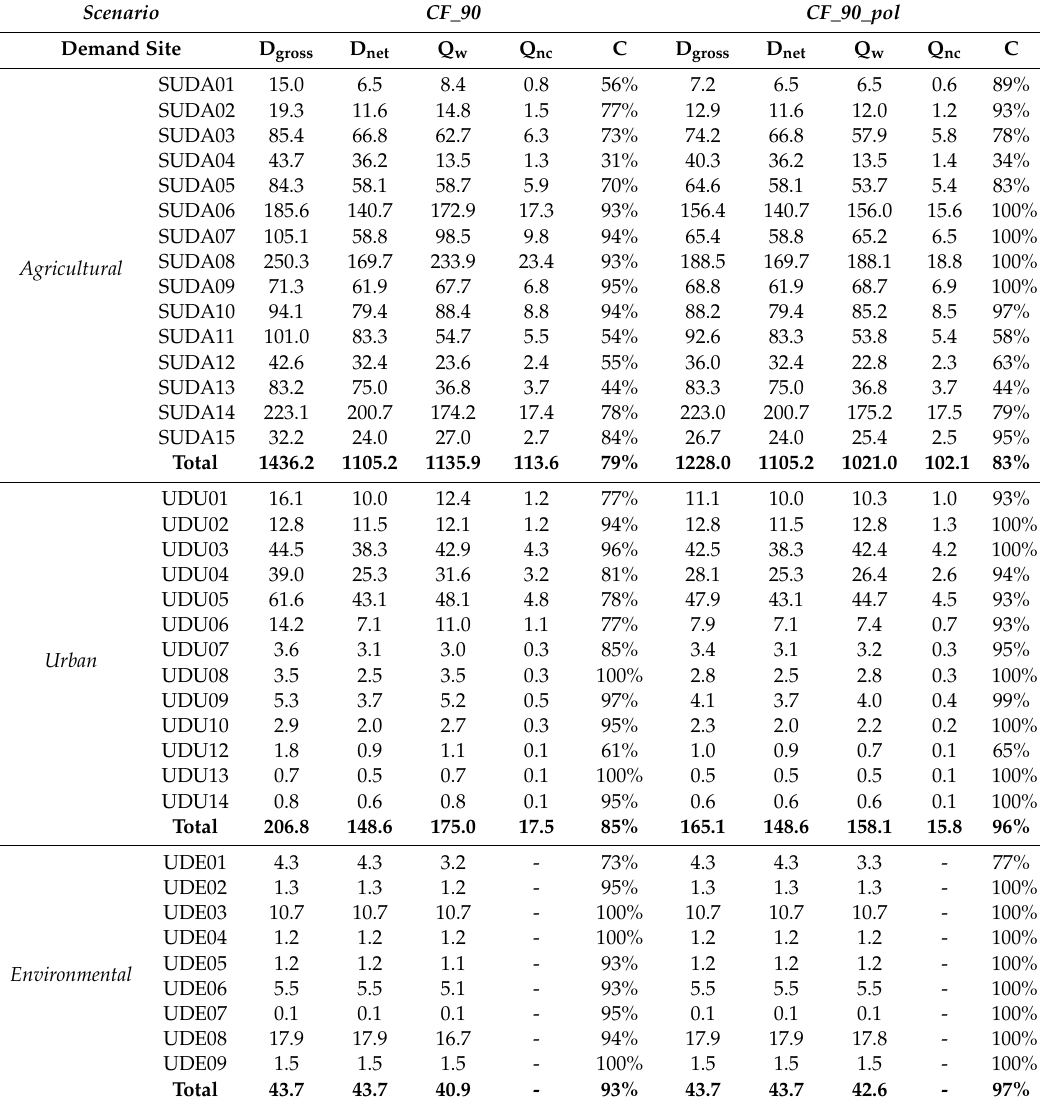
Table A2. Demand, supply, return flow, and coverage at the demand site level under the CF_90 and CF_90_pol scenarios, in which the Consumed Fraction of all agricultural and urban demand sites is set to 0.9. D gross = gross demand (hm 3 / year), D net = net demand (hm 3 / year), Q w = total